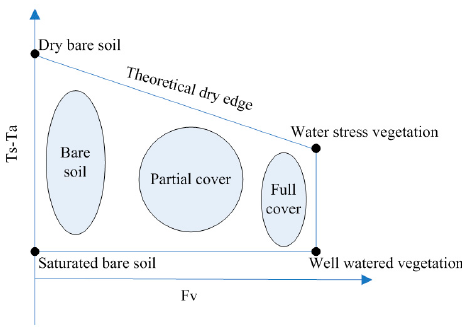
Figure 3. The simplified trapezoidal space between Ts-Ta and Fr [31].